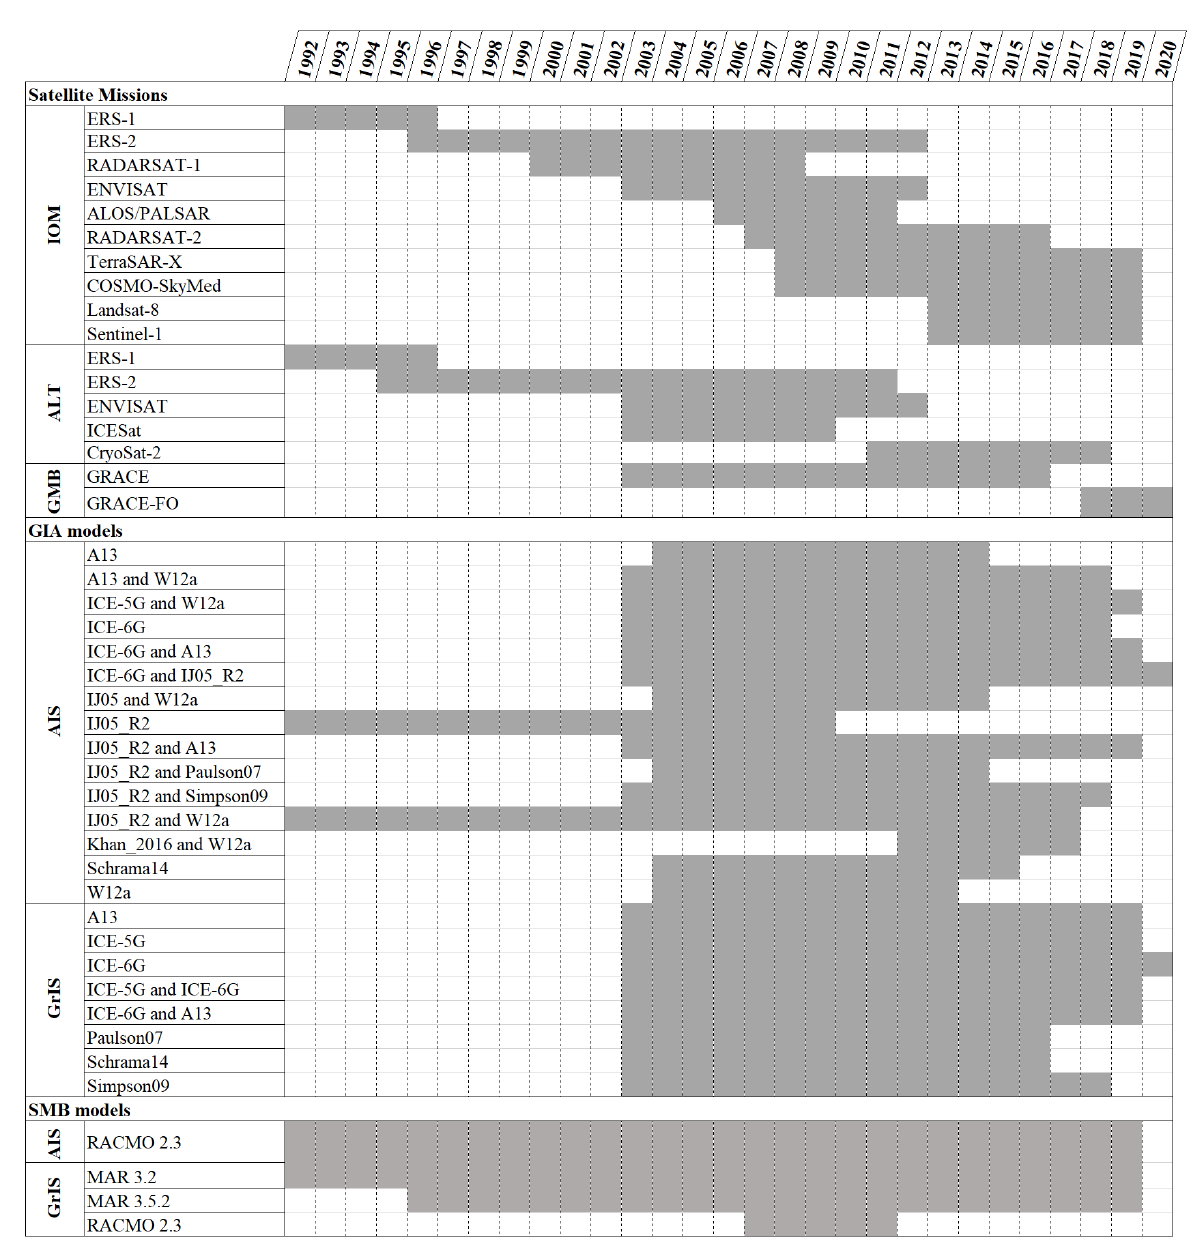
Table 1. Synthesis of satellite datasets, GIA, and SMB models used to derive the individual estimates of ice sheet mass balance included in this study. Details and references of the GIA and SMB models are available in Table